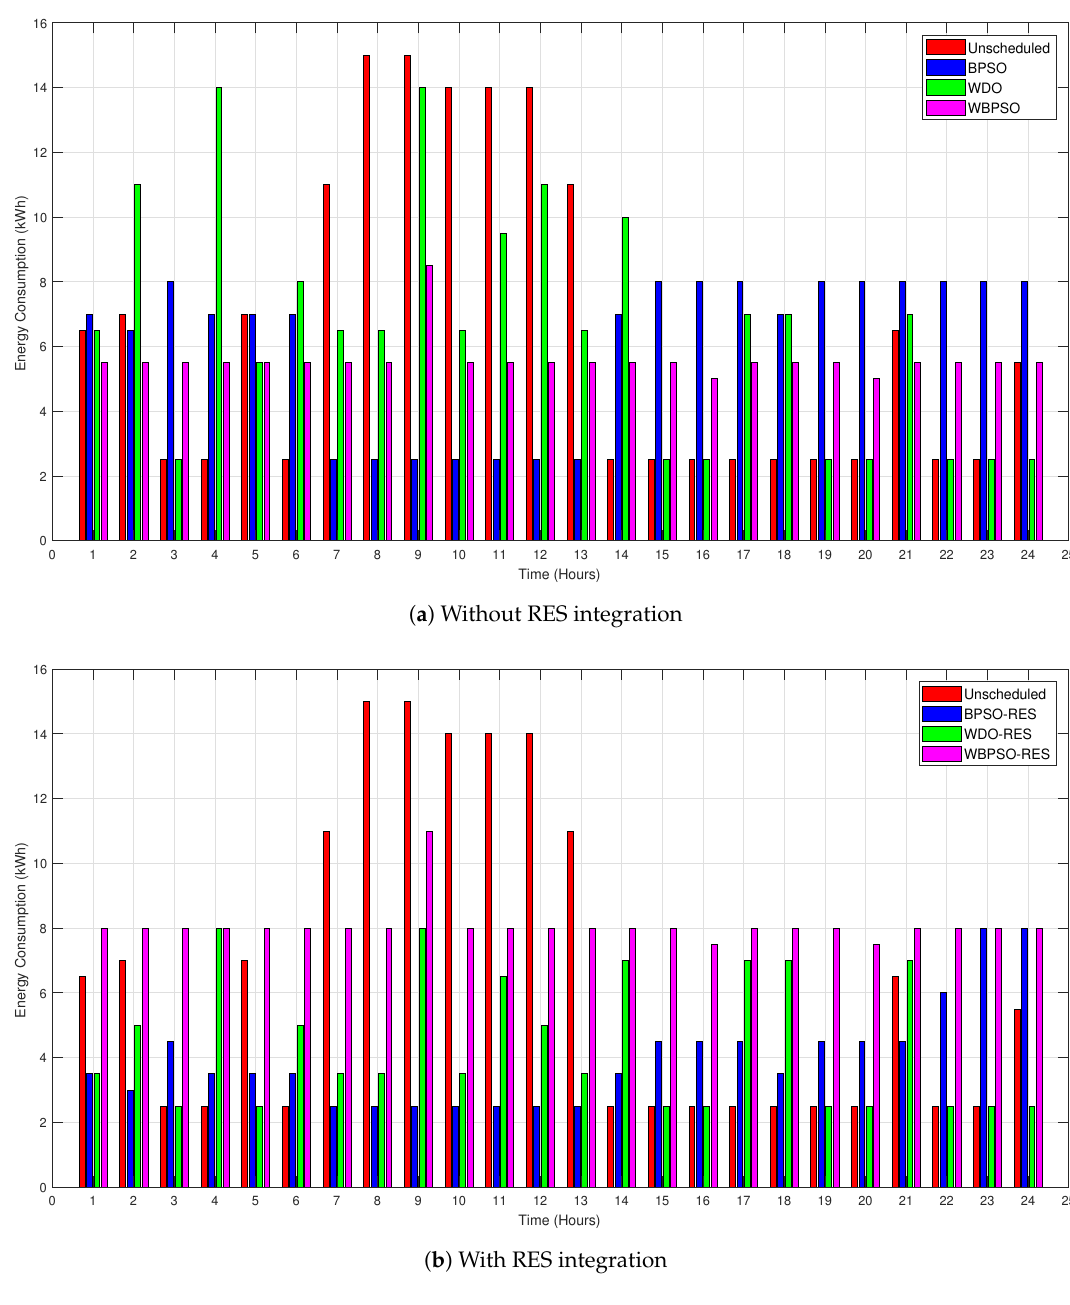
Figure 6. Energy consumption profile by